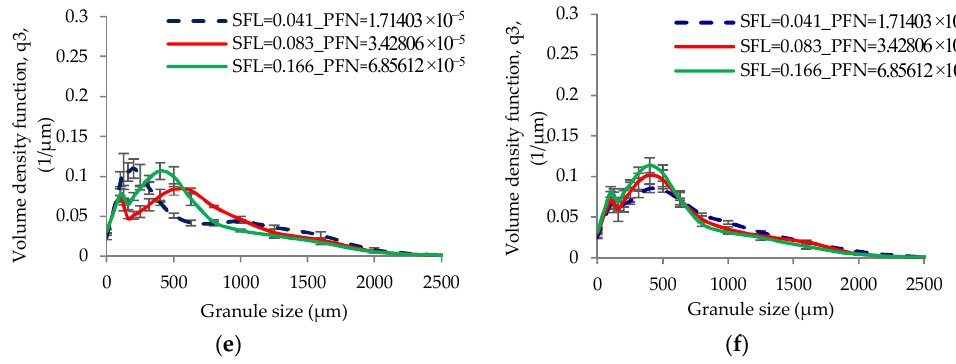
Figure 6. Granule size distribution of lactose (L/S 0.048) at different SFL–PFN at varying screw speed. ( a ) 150 rpm; ( b ) 250 rpm; ( c ) 400 rpm; ( d ) 500 rpm; ( e ) 750 rpm; and ( f ) 1000 rpm.